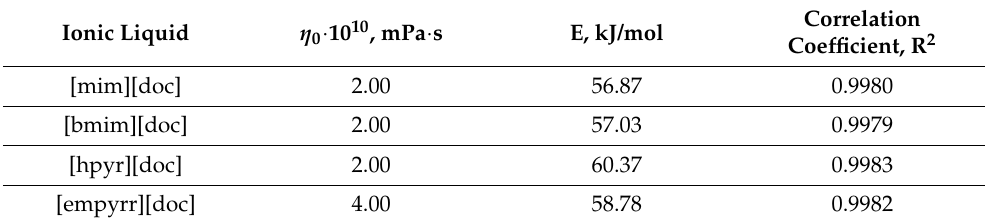
Table 3. The activation energy for ILs, calculated by the Guzman–Andrade